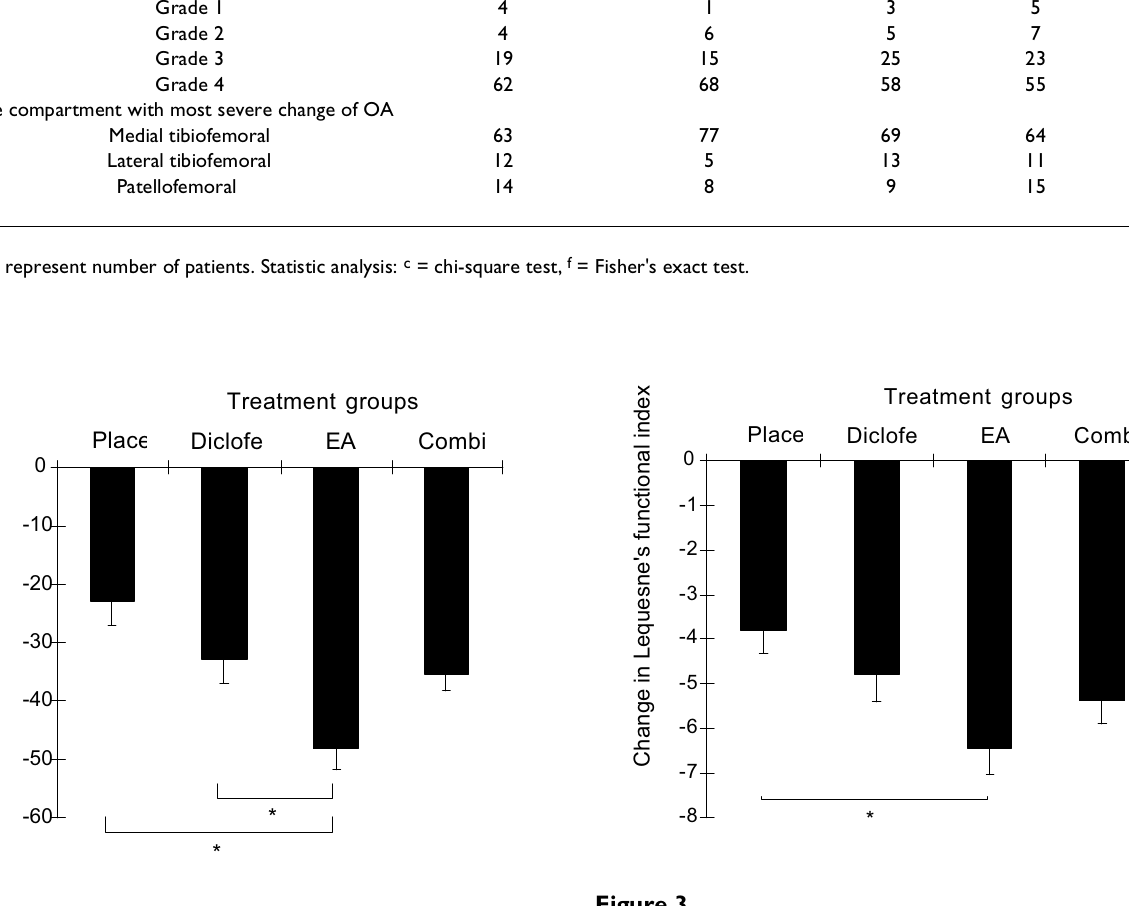
Treatment groups